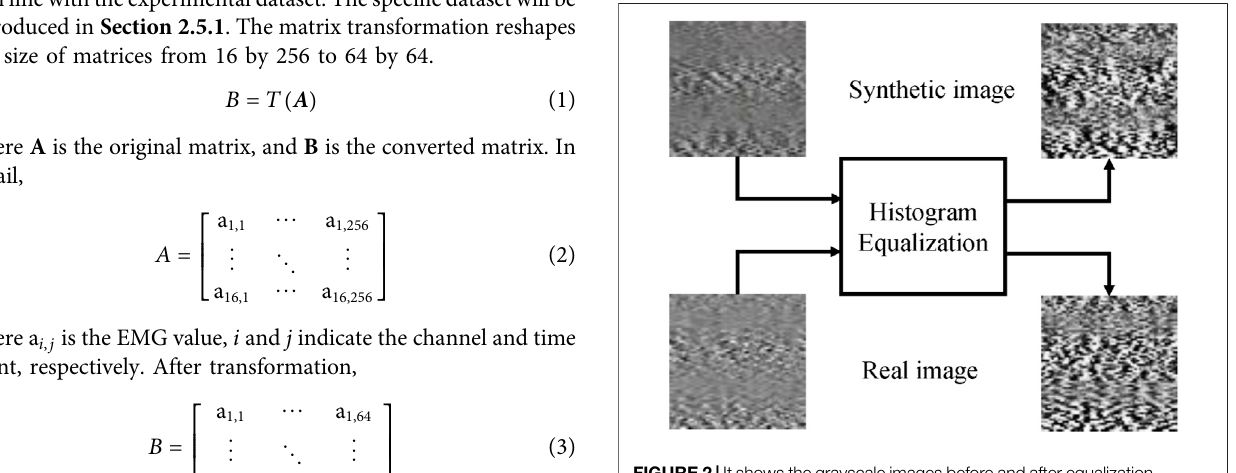
FIGURE 2| It shows the grayscale images before and after equalization. The top two images are synthetic images, and the bottom two are real